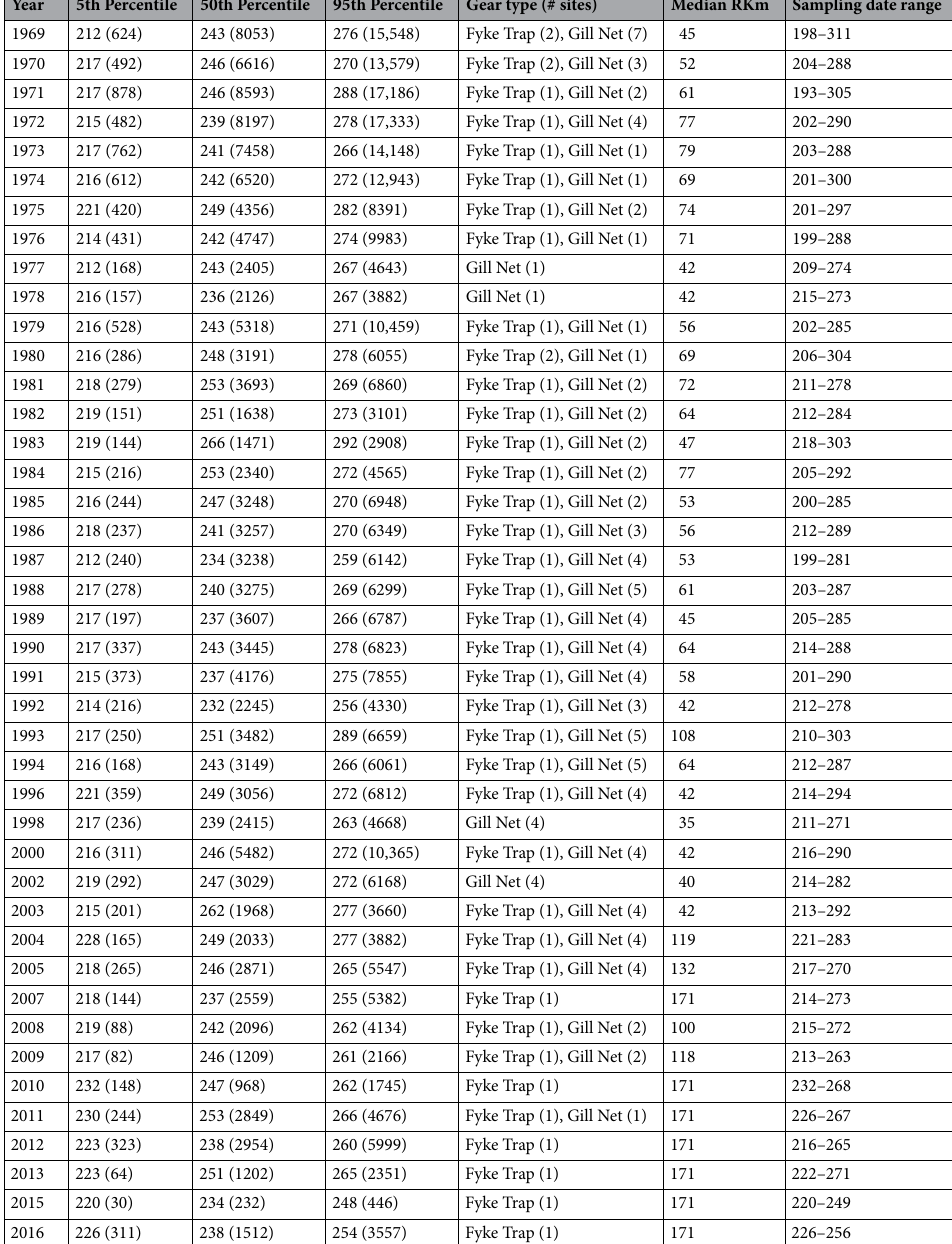
Table 1. A summary of the San Francisco Bay-Delta Interagency Ecological Program’s (IEP) Striped bass Population Study, which captured 307,727 adult Striped bass over the forty-two years examined in this study and exhibited inconsistency in sampling through time. The early (5th percentile), middle (50th percentile) and late (95th percentile) phase of upstream migration of Striped bass for each year was calculated. In these estimates of migration timing, the day of year corresponds to an October 1 to September 30 calendar, which parallels the accumulation of precipitation in California, ecology of juvenile Chinook salmon and is commonly referred to as a “water year”. The cumulative number of individuals captured is provided in parentheses. The sampling inconsistencies are summarized by the gear used and number of locations for each gear in parentheses, median river kilometer (RKm) where fish were captured, and range of capture days (date range of capture data was used as zero data was not provided, and reportedly